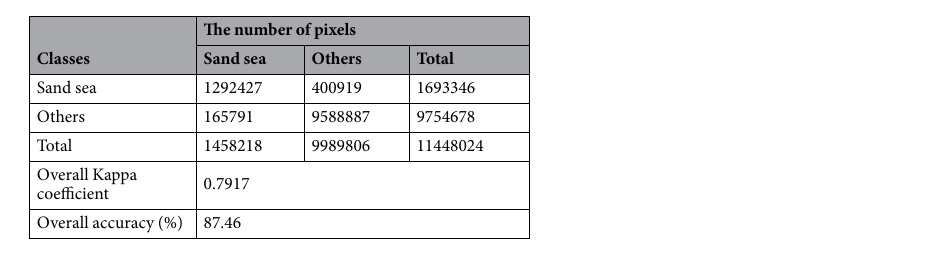
Table 2. The accuracy analysis of change detection technique for Rigboland sand